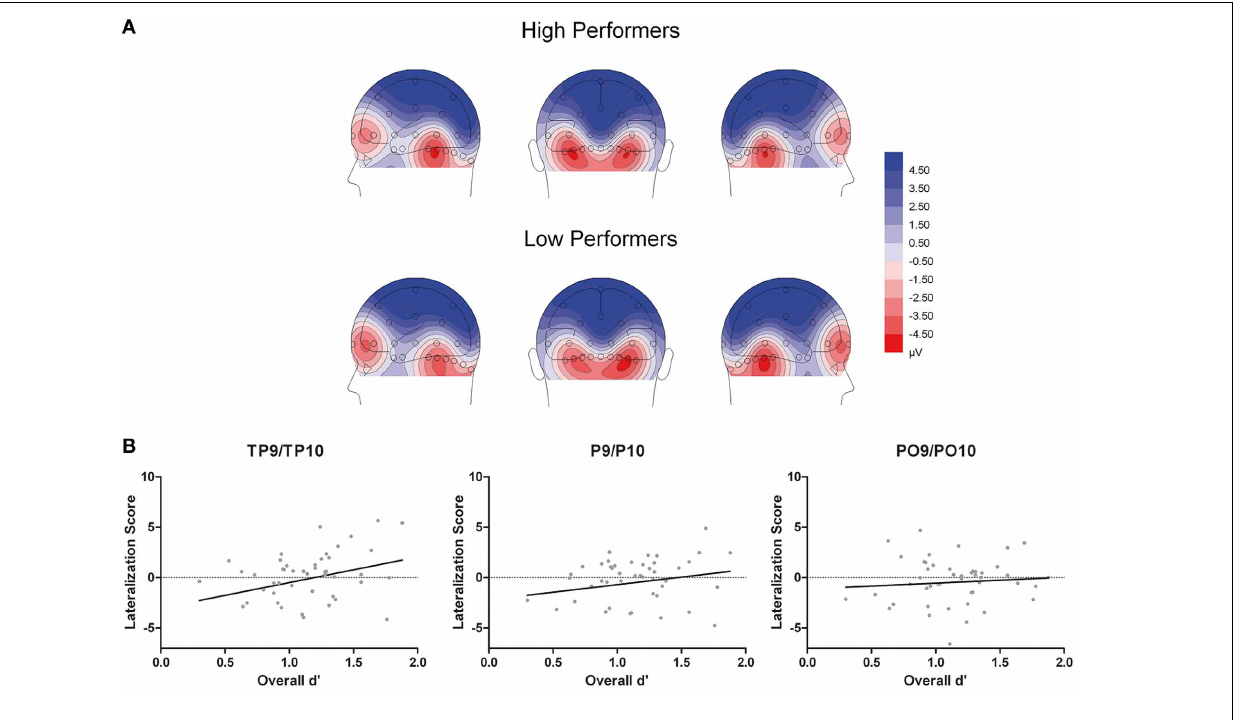
older adults. (B) Scatter plots depicting the correlations between N170 amplitude (right hemispheric - left hemispheric amplitudes across experimental conditions) and overall memory